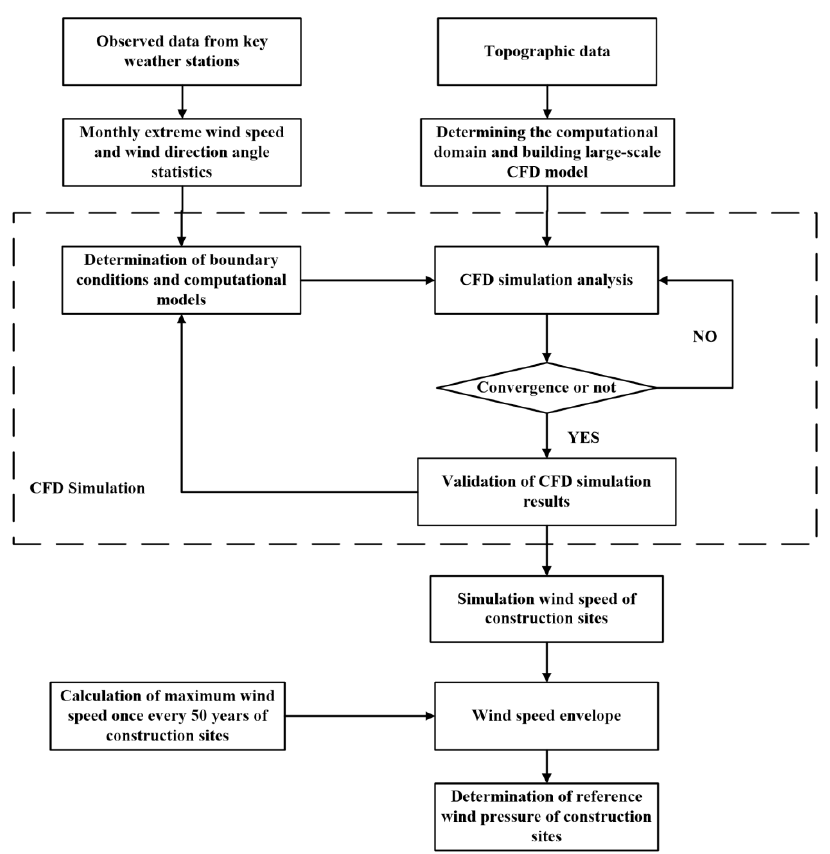
Figure 4. The overall procedure to determine the reference wind pressure.